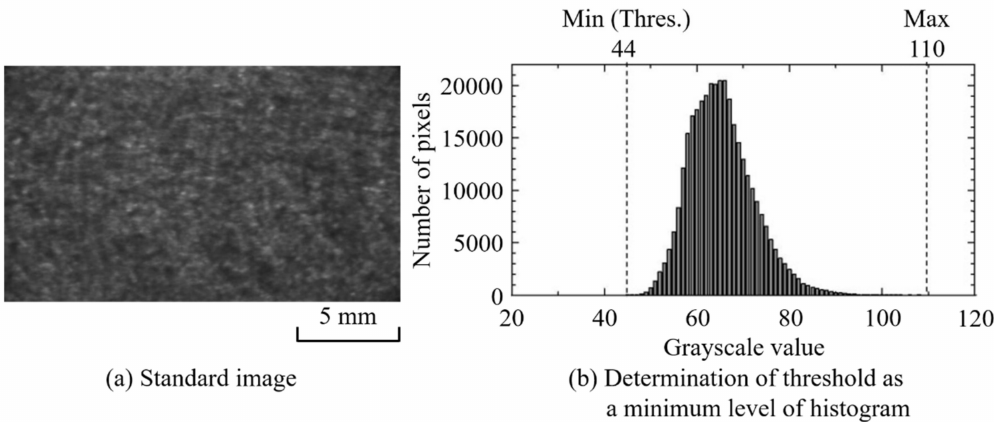
Figure 5. Standard image to determine the value of the threshold (glass fiber reinforced PP; BP = 12 MPa, Shot No. 1).